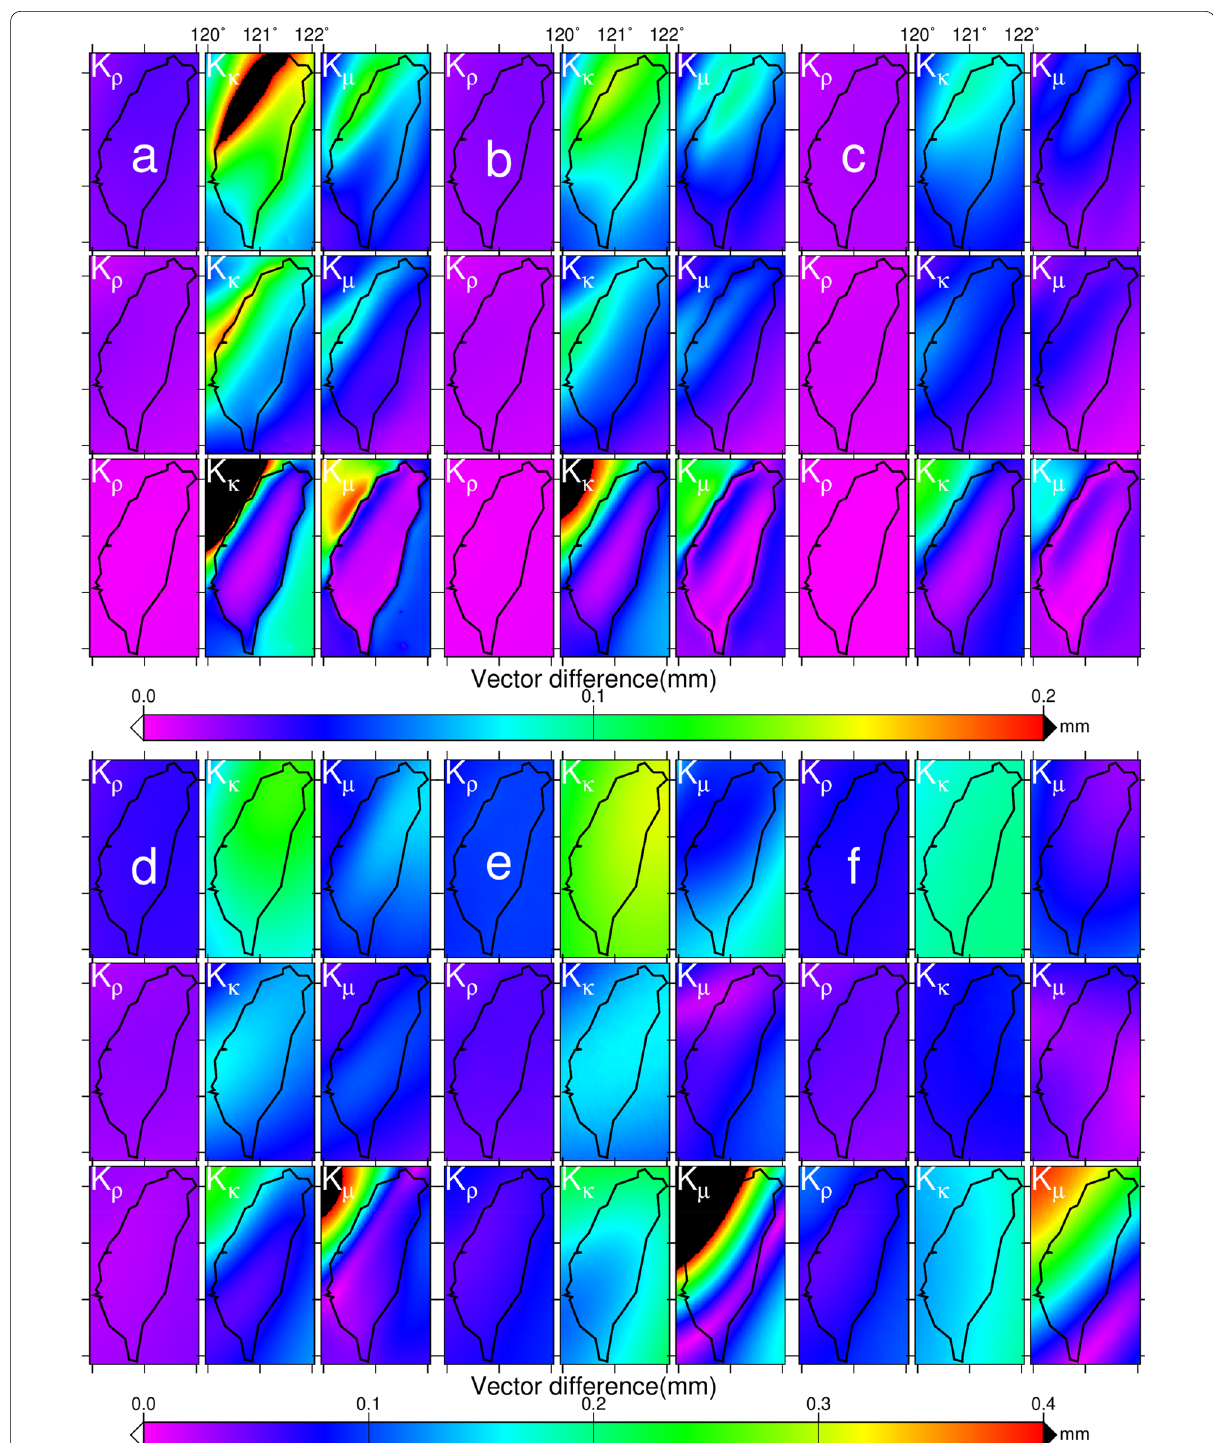
Fig. 7 Vector discrepancies of the modeled M 2 OTL displacements to 10% linear perturbations in TW1. The modeled M 2 OTL displacements in the + east component (top panel), north component (middle panel), and vertical component (bottom panel) to 10% linear perturbations of the density + (left), bulk modulus (middle), and shear modulus (right) in the upper crust (a), middle crust (b), and lower crust (c) of TW1 with scales of 0–0.2 mm; and in the LID (d), LVZ (e), and region above the transition zone (f) of TW1 with scales of 0–0.4 mm. The depths of the perturbed layers: the upper crust (0–13.88 km depth), middle crust (13.88–24.52 km depth), lower crust (24.52–32.15 km depth), LID (32.15–80 km depth), LVZ (80–220 km depth), and region above the transition zone (220–400 km